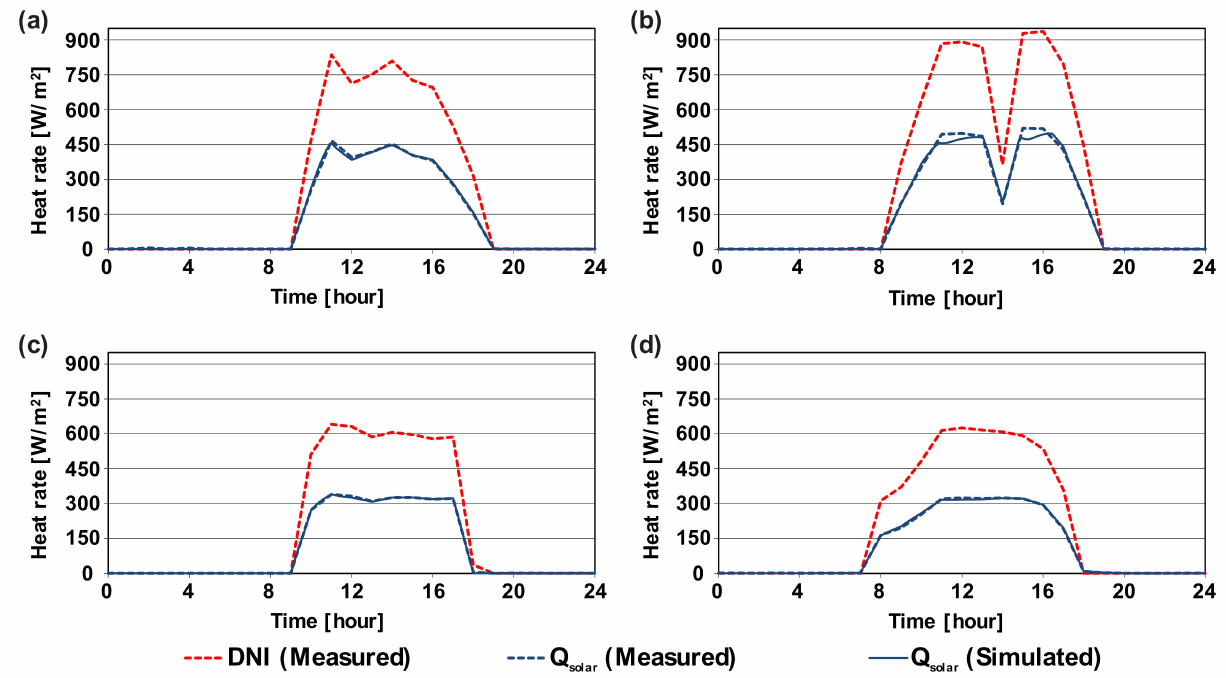
Figure 7. The rates of heat absorption from the solar field for four days: ( a ) 20 July 2013; ( b ) 21 July 2013; ( c ) 30 August 2013 and ( d ) 4 September